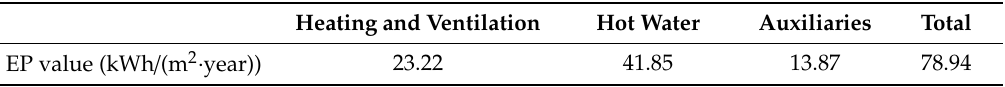
Table 4. The annual primary energy demand EP (kWh / (m 2 · year)) for the multi-family building at Sadowskiego Street in Szczecin. Heating and Ventilation Hot Water Total